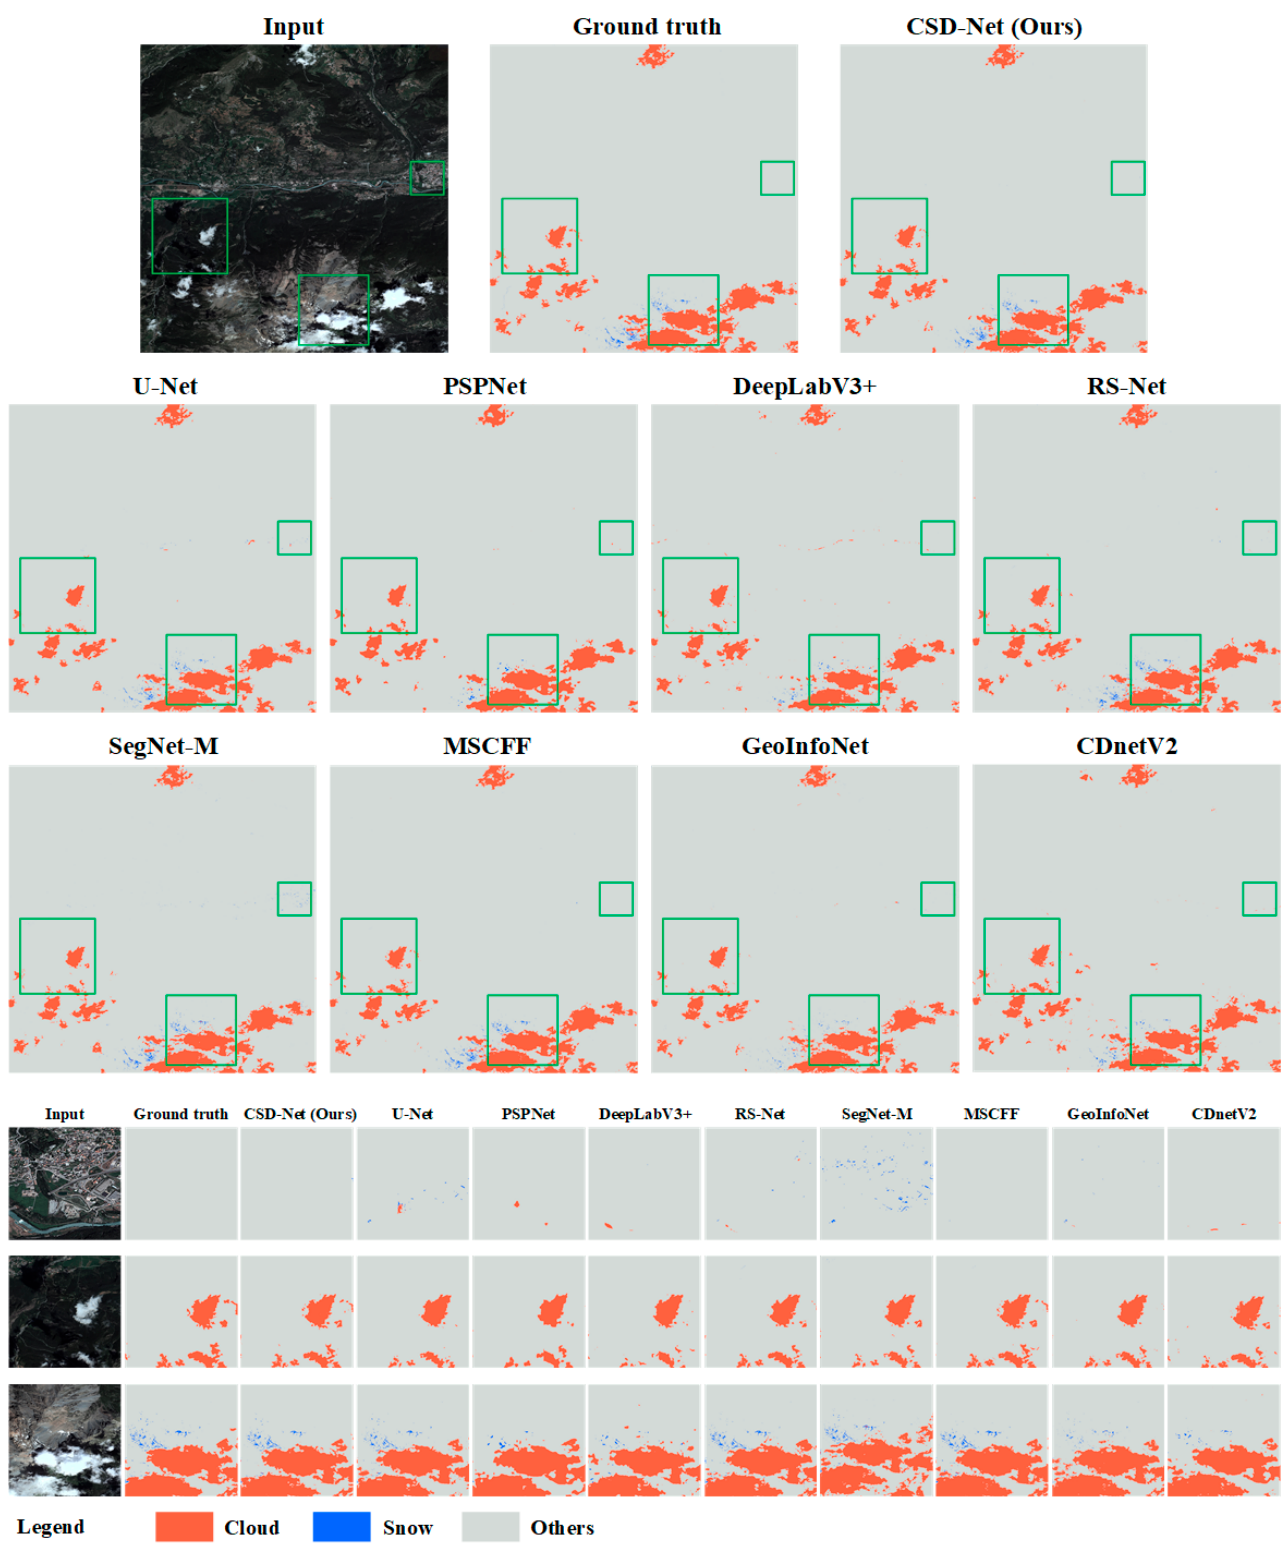
Figure 10. Large scene visualization of cloud and snow detection results by different methods based on the CSWV_M21 dataset. The delineated areas with the green boxes were magnified to provide a more detailed visual comparison in the bottom columns.